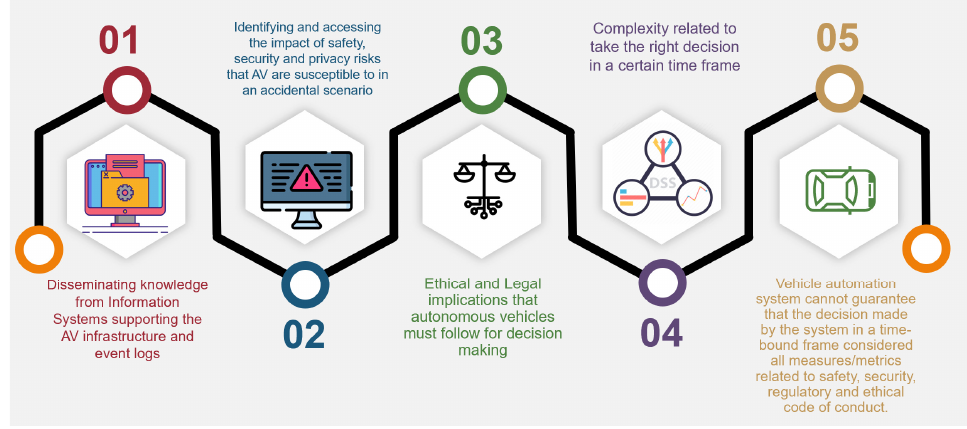
Figure 3. Ethical dilemmas related to AV’s decision making (the diagram is adapted from manage- ment strategies for Autonomous Vehicles [19] and redesigned in context of this research) Table 3. Ethical dilemmas in Autonomous vehicles.